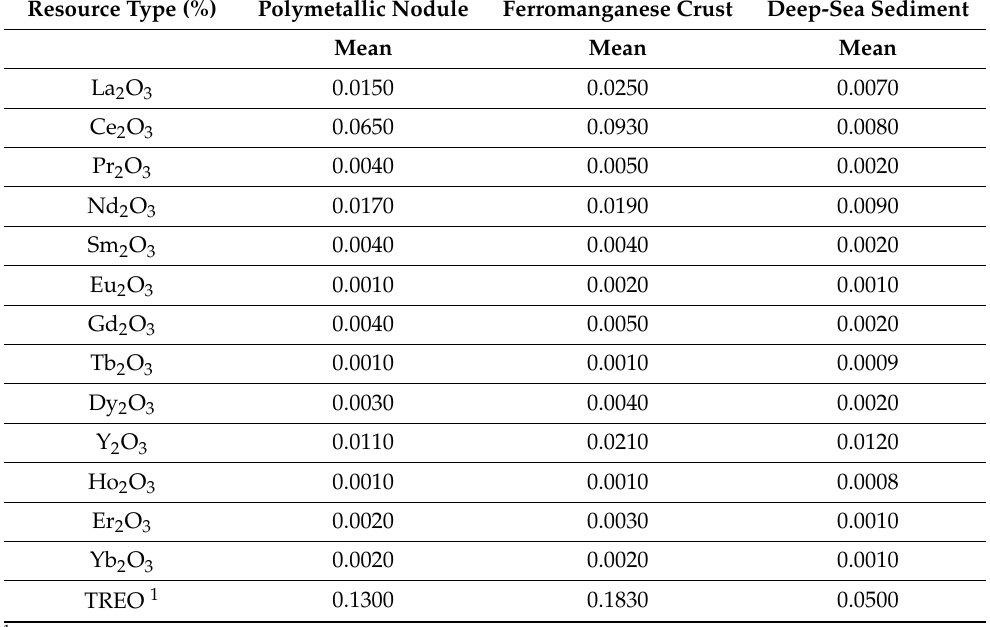
Table 4. REO contents (%) of Mn–Fe nodules, ferromanganese crusts and deep-sea sediments within the Korean licences in the CCZ [8].